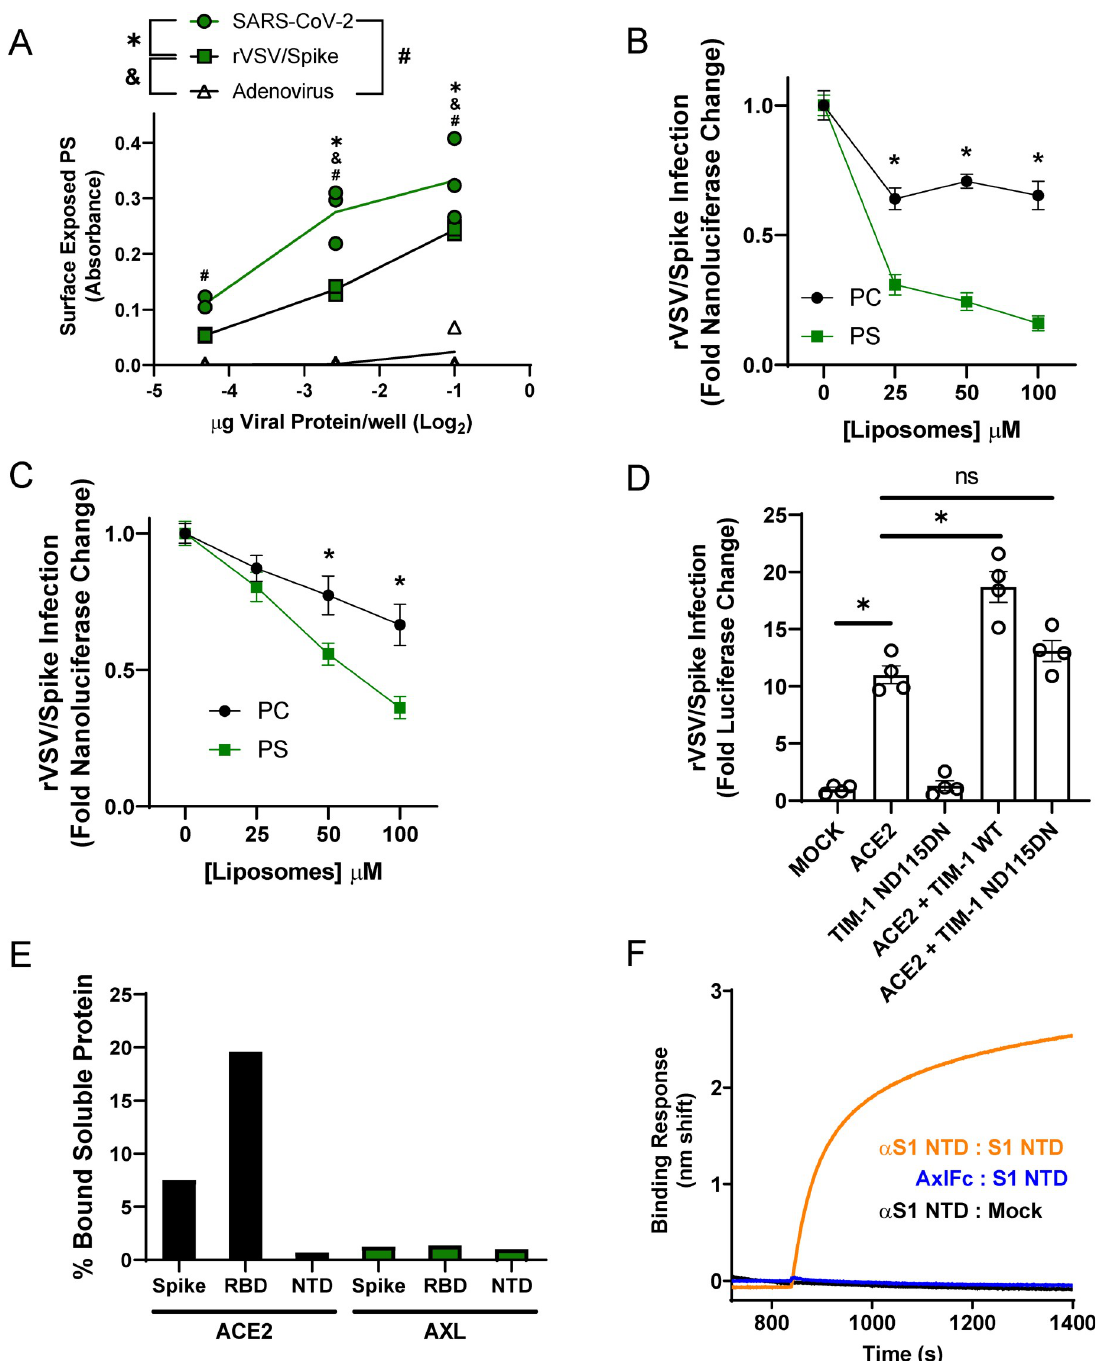
Fig 2. PS receptors interact with SARS-CoV-2 by binding to virion PS. A) PS is readily detectable on UV irradiated SARS-CoV-2 virions and rVSV/Spike. Indicated quantities of viral particles (determined by protein content) were coated in ELISA plates, and PS was detected using bavituximab followed by secondary antisera . B-C) PS liposomes interfere with rVSV/Spike infection. HEK 293T cells transfected with 50 ng of ACE2 plasmid and 1 μ g of TIM-1 ( B ) or AXL ( C ) plasmid. Cells were infected with rVSV/Spike in the presence of increasing concentrations of PS or PC liposomes and assessed for nanoluciferase activity 24 hours later. D) HEK 293T cells were transfected with 1 μ g of plasmid expressing WT or PS binding pocket mutant TIM-1 (ND115DN) with or without 250 ng of ACE2 plasmid and infected 48 hours later with rVSV/Spike. Luminescence fold change were compared to Mock transfected lysates that were set to a value of 1. E) Surface expressed AXL is unable to directly interact with purified SARS-CoV-2 spike/Fc proteins. HEK 293T cells transfected with AXL or ACE2 were incubated with soluble Spike protein-Fc, S1 RBD-Fc or S1 NTD-Fc and subsequently incubated with